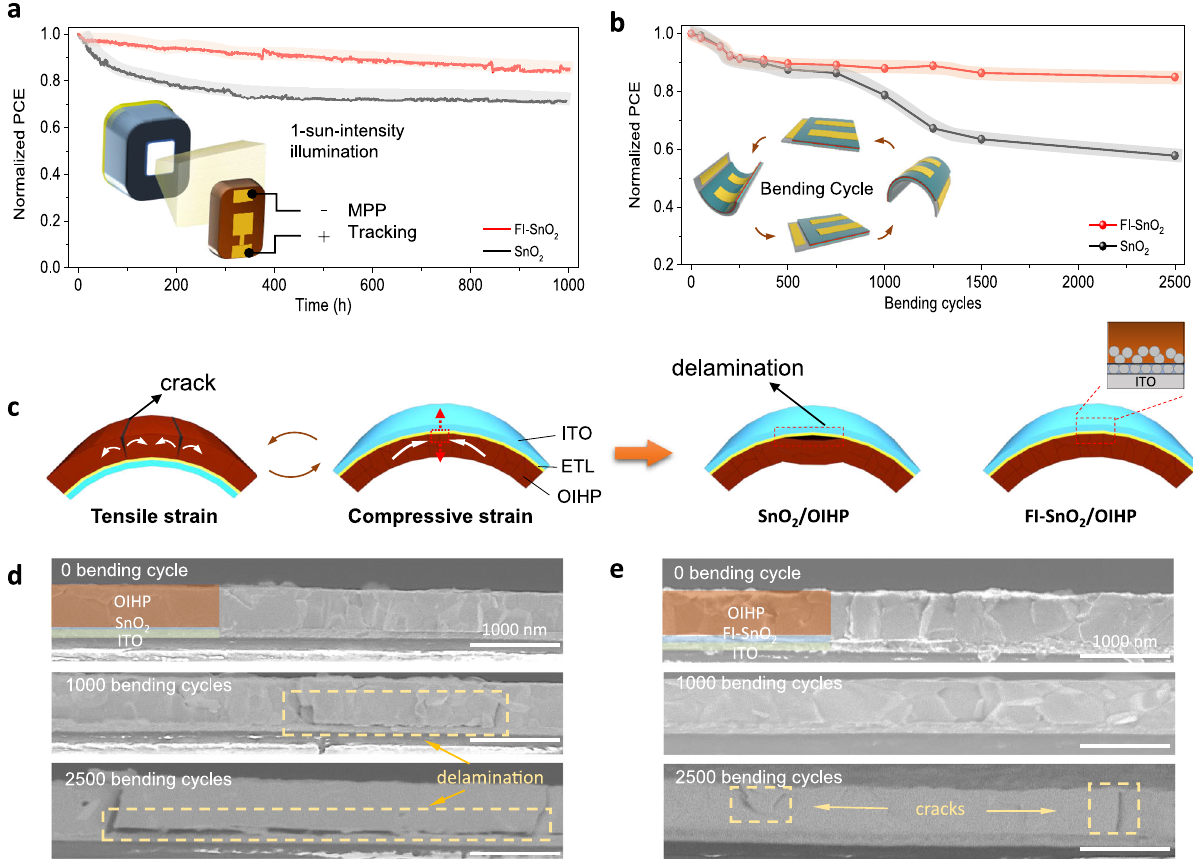
Fig. 5 Operational stability and mechanical durability of solar cell devices. a Operational stability of rigid PSC devices based on FI – SnO 2 and pristine SnO 2 ETLs under continuous light illumination (one-sun intensity illumination; fl owing N 2 ; 40 °C). b Durability of fl exible PSC devices based on FI – SnO 2 and pristine SnO 2 ETLs as a function of mechanical bending cycles (40% RH; ambient air; 25 °C; 3 mm minimum r ); Inset illustrates a typical mechanical bending cycle. c Schematic illustrations showing the strains in OIHP layers under different bending states (left panel) and the fi lm states after bending cycles (right panel). d , e Cross-section SEM images of fl exible PEN/ITO/SnO 2 /OIHP fi lm and PEN/ITO/FI – SnO 2 /OIHP fi lm after different bending